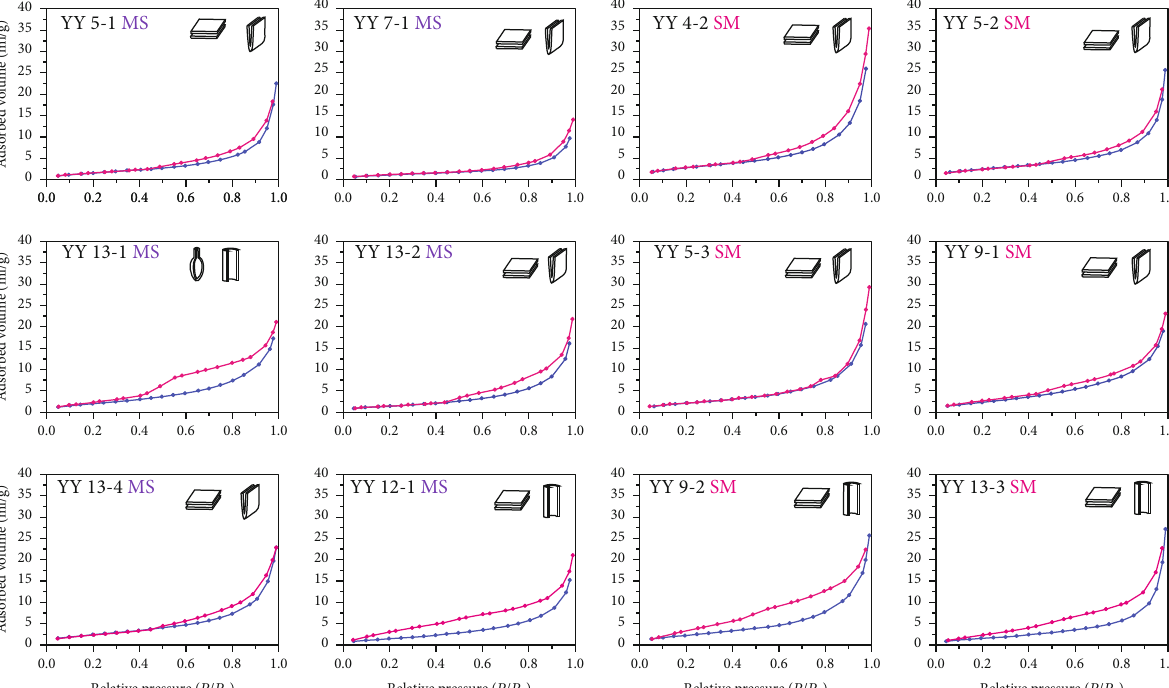
isotherms for the Chang 7 shale 2